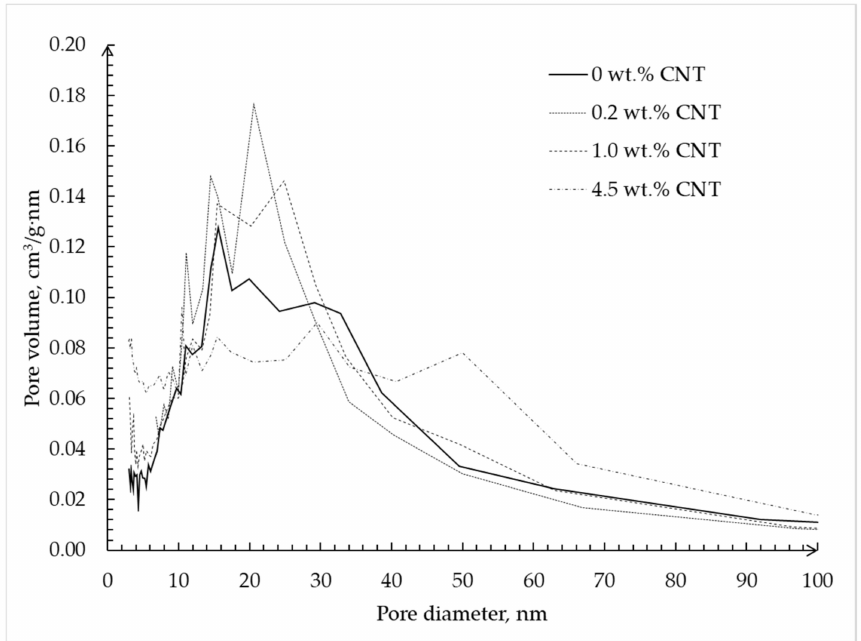
Figure 7. Pore size distribution calculated using the Barrett–Joyner–Halenda (BJH) method based on desorption isotherms of silica hybrid aerogel microparticles with embedded CNTs.